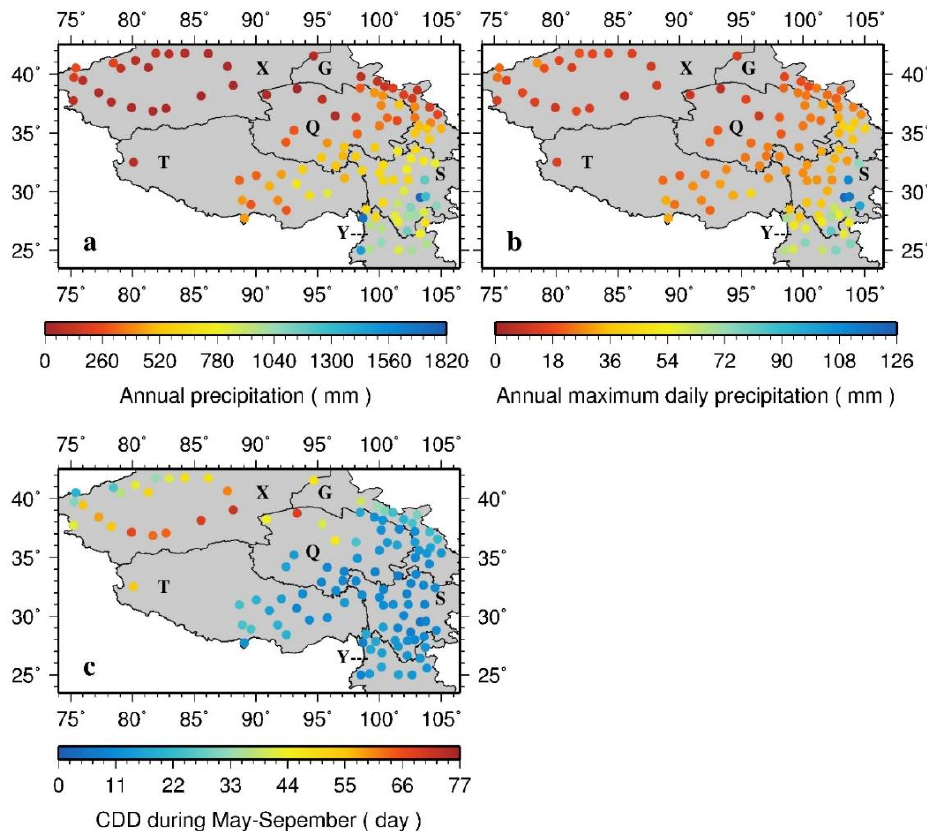
Figure 3. ( a – c ) Spatial distributions of annual precipitation variables.